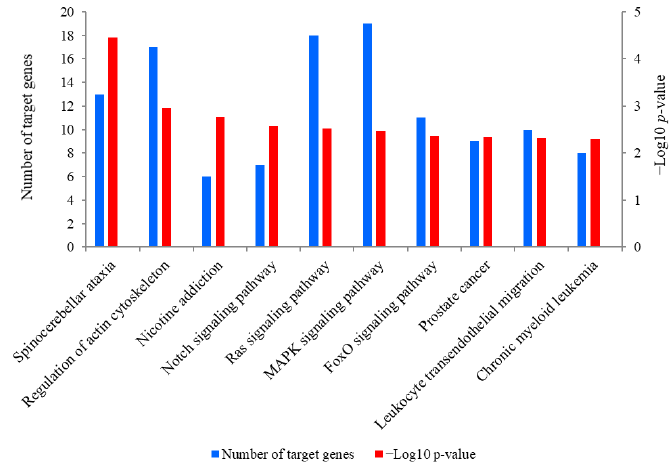
Figure 5. The top 10 KEGG pathways enriched for predicted target genes of miR-381. The left-hand Y-axis represents the number of the target genes of miR-381 involved in a pathway, while the Y axis on the right side shows the value of − Log10 ( p -value). on the right side shows the value of − Log10 ( p